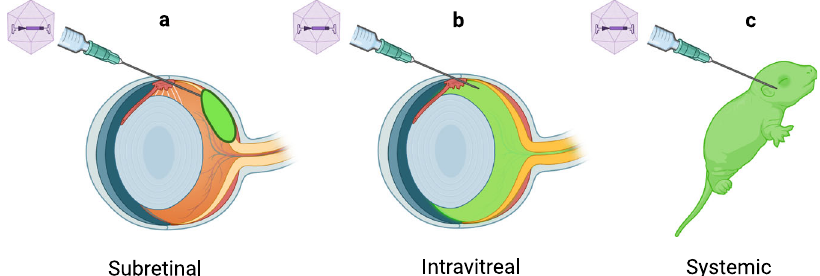
Fig.1|IllustrationofAAVadministrationroutes.a Subretinalinjectionsresultinhightransductionoftheouterretinaundertheinjectionssite. b Intravitrealinjections deliver vector across the inner retina. c Intravenous injections via the facial vein deliver AAV